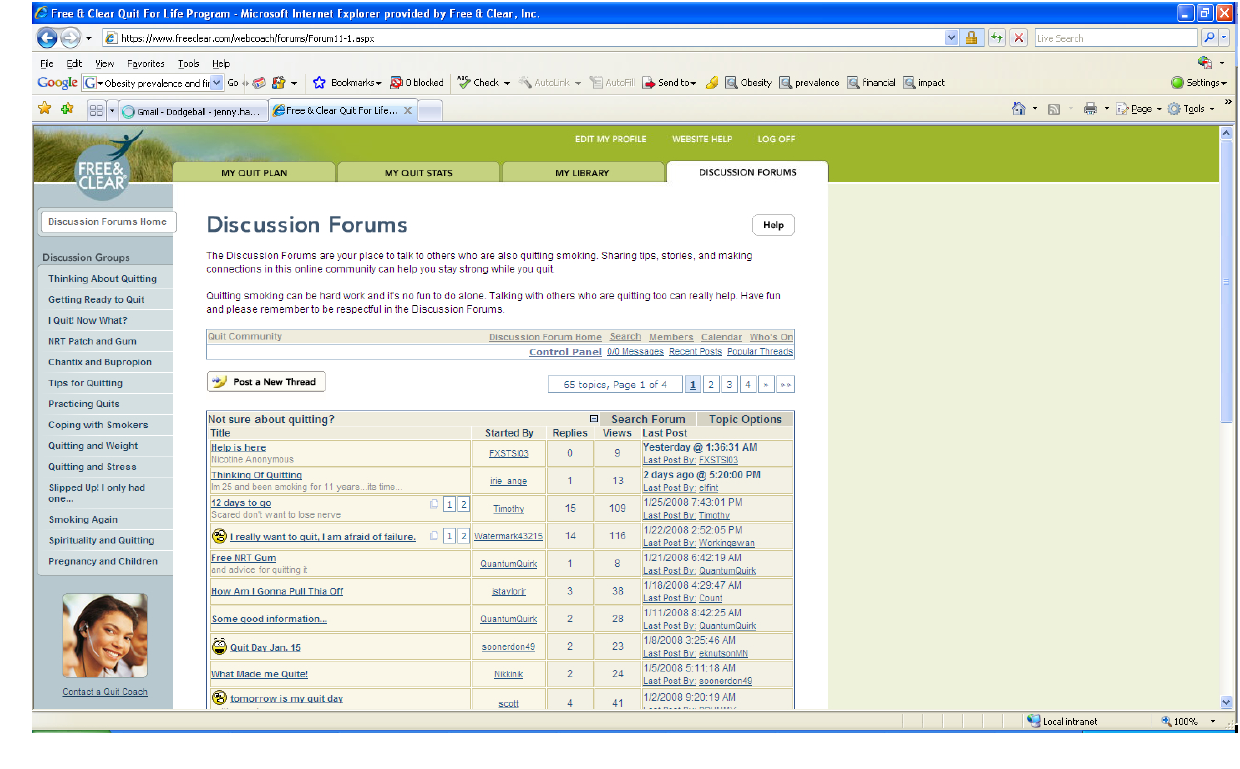
Figure 8. Relapse-prevention